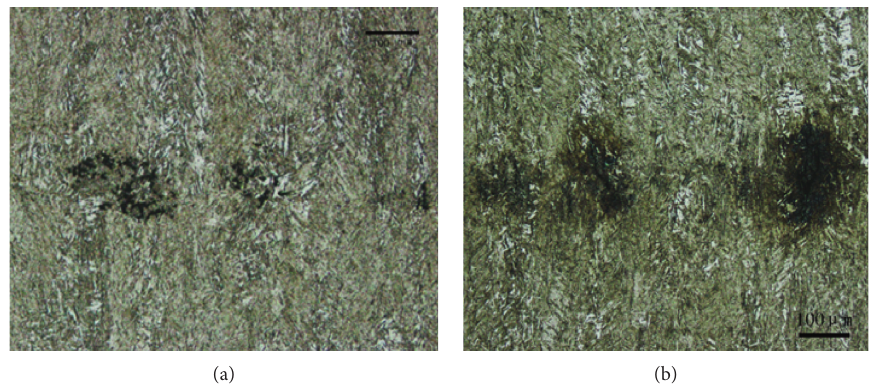
Figure 8: Loose defects. (a) QP980 steel RSW; (b) TRIP800 steel RSW.